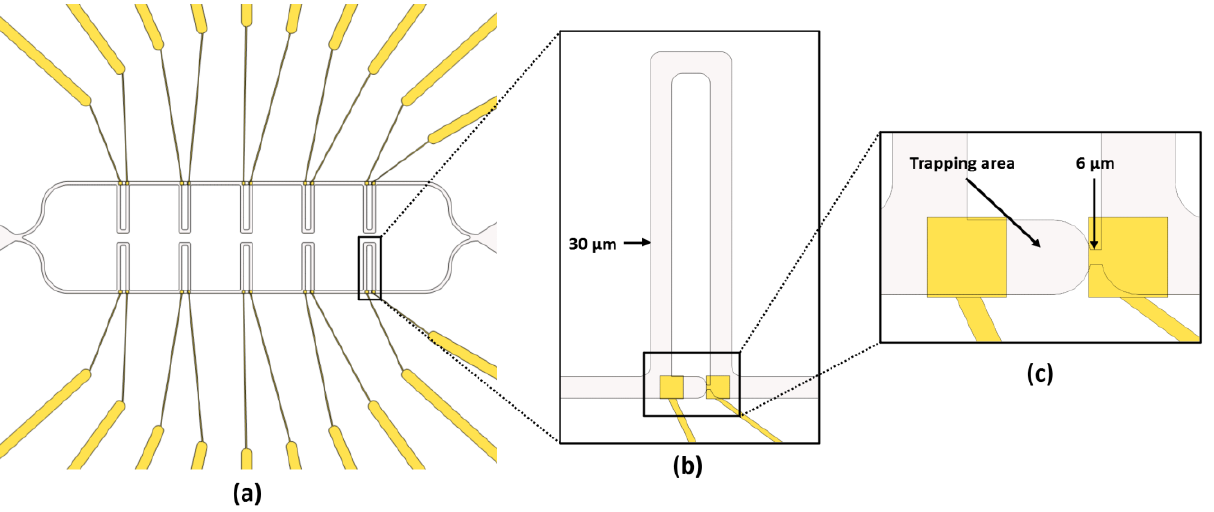
Figure 3. ( a ) Schematic view of the microfluidics channels (in gray) and microelectrodes for BIS interrogation (in yellow). ( b ) Two channels of a cell trap on a microelectrode pair. ( c ) The shorter channel of the microfluidic trap on a microelectrode pair when the cell becomes trapped.